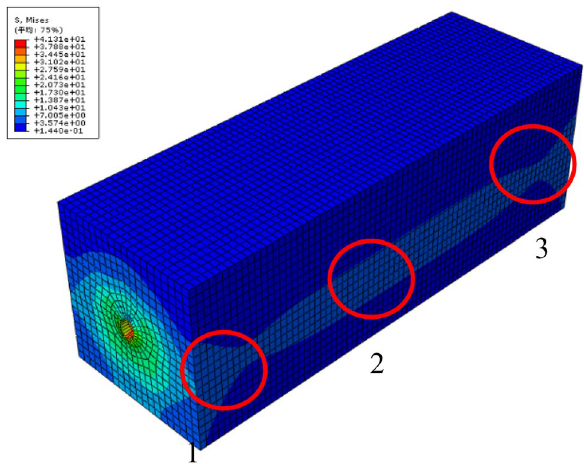
Figure 5. Mess stress in numerical simulation under nonuniform corrosion.